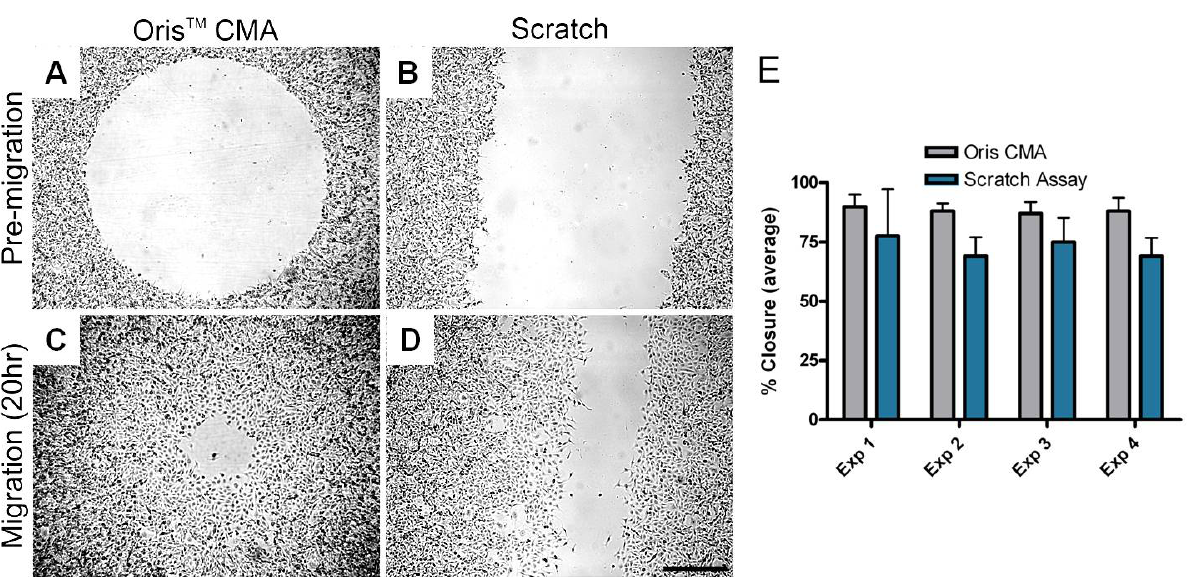
Figure 5. Comparison of MDA-MB-231 human breast epithelial cell migration using the Oris™ Cell Migration Assay and the scratch assay. MDA-MB-231 cells were seeded into collagen I coated Oris™ assay plates with stoppers at 25,000 cells/ 100 µL or in collagen I coated 6-well plates at 500,000 cells/2 mL. Once confluent monolayers were formed, the cells were serum starved for 24 hours. To initiate migration, the stoppers were removed from the Oris™ assay plate and the monolayers were scratched using a 1,000 µL pipet tip in the 6-well plates. The media in both assays was replaced with serum-containing media. Representative phase images of pre-migration ( A and C ) and migration after 20 hours ( B and D ) in the Oris™ ( A and B ) and the scratch ( C and D ) assay were captured using a Zeiss Axiovert microscope with an attached CCD camera. Scale bar = 500 µm. Graph of 4 independent experiments comparing cell migration using the Oris™ and scratch assays in parallel ( E ). Images were analyzed using ImageJ analysis software and data presented as average percent closure ± SD (n ≥ 12